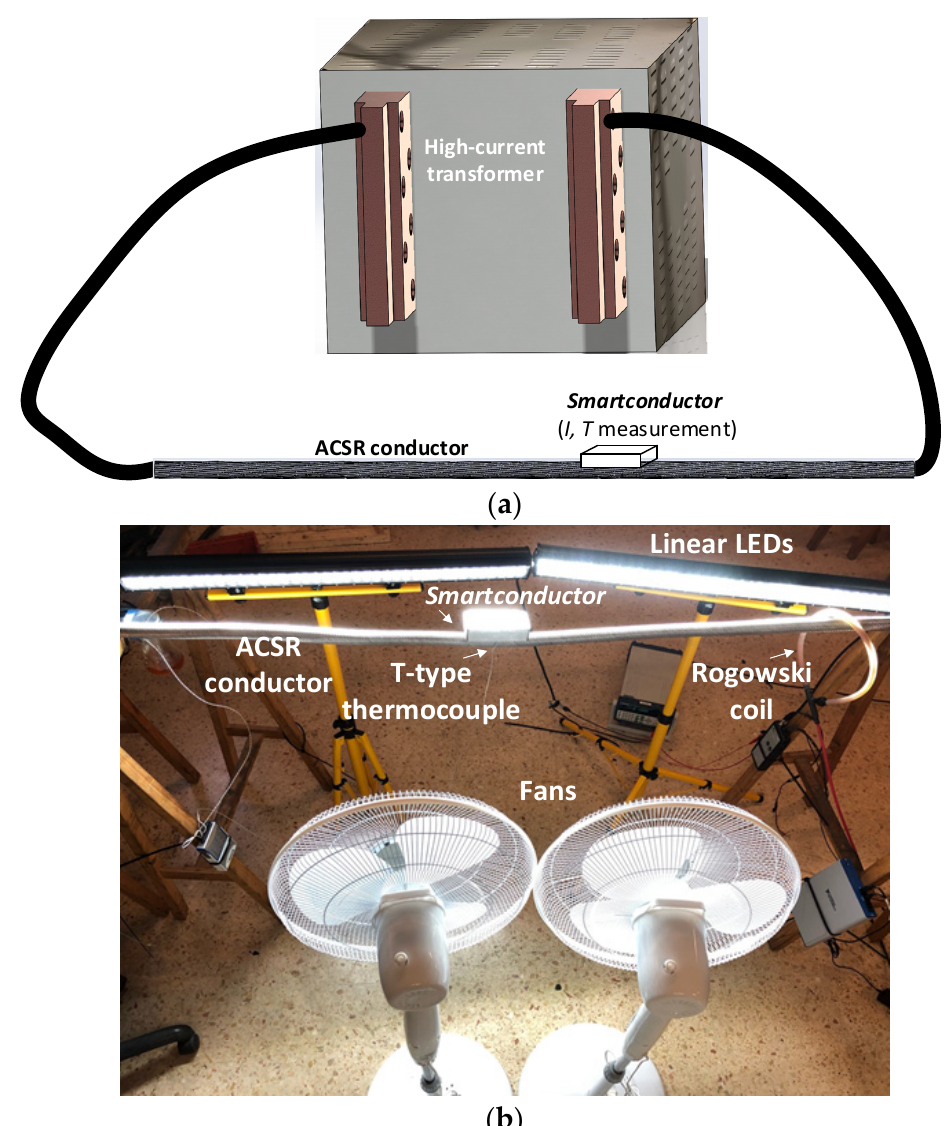
Figure 4. ( a ) Sketch of the experimental setup; ( b ) detail of the ACSR conductor and the sensors.